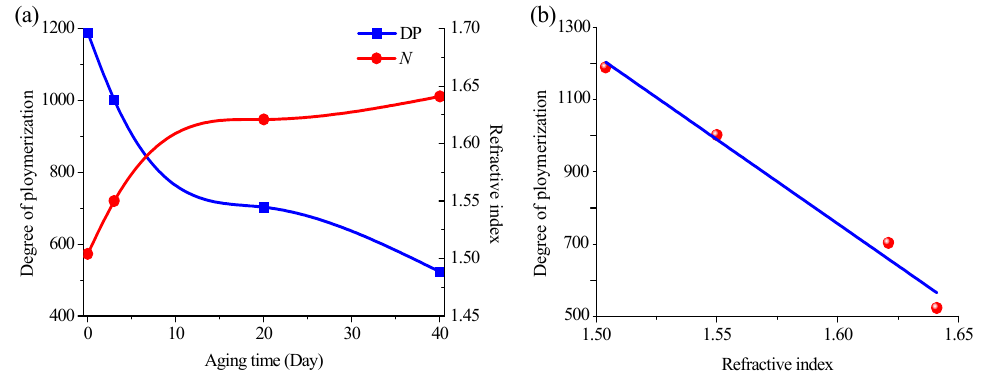
Figure 4. ( a ) Curves of refractive index and degree of polymerization (DP) of insulation paper; ( b ) DP vs. refractive index of paper.